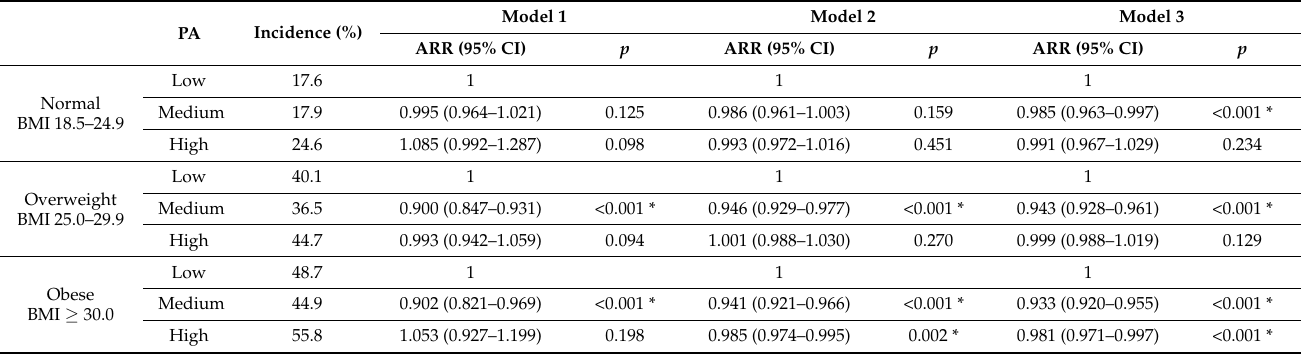
Table 4. Incidence of primary hypertension and adjusted relative risk according to BMI and physical activity classifications. Model 1 Model 2 Model 3 PA Incidence (%) ARR (95% CI) p ARR (95% CI) Normal BMI